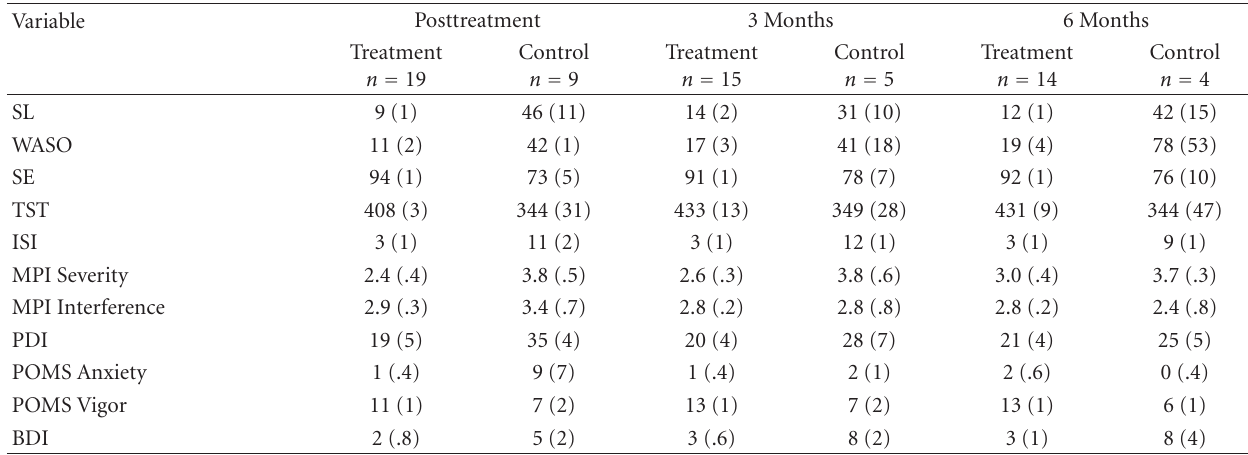
Table 3: Least-square Means (sd) by